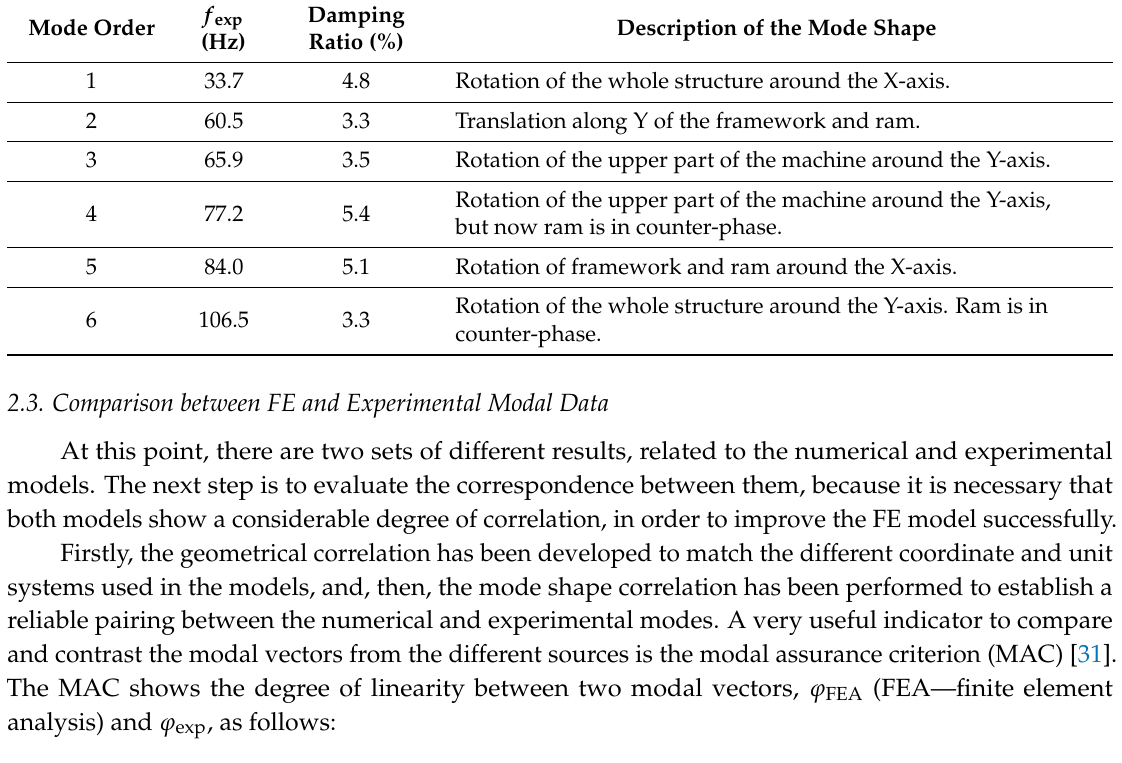
Table 3. Natural frequencies and mode shapes obtained by experimental modal analysis.